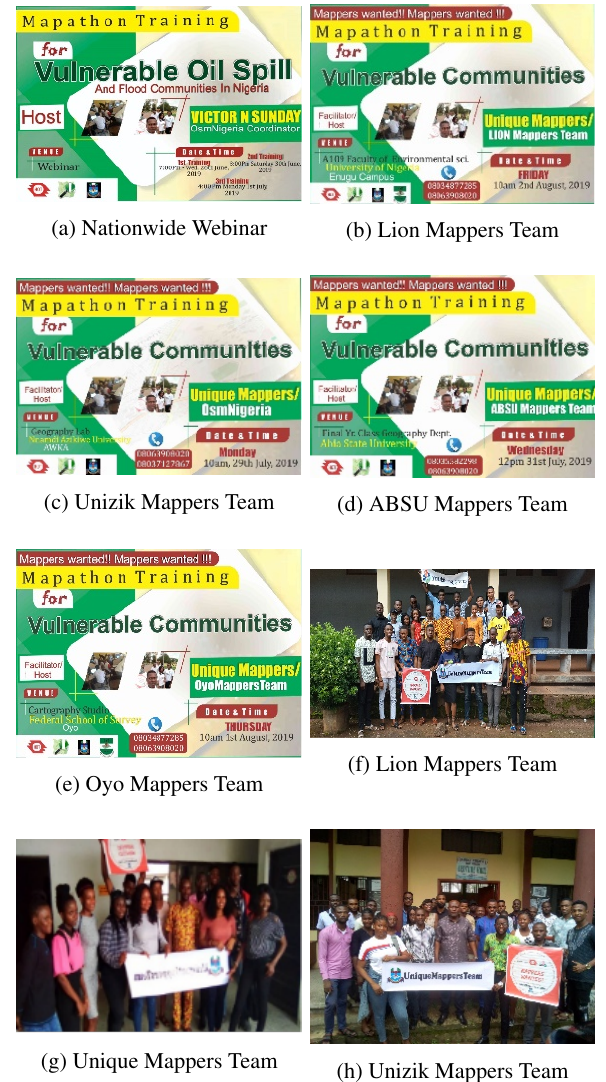
Figure 3: Samples of campaign flyers and mobilized LVM trainees for